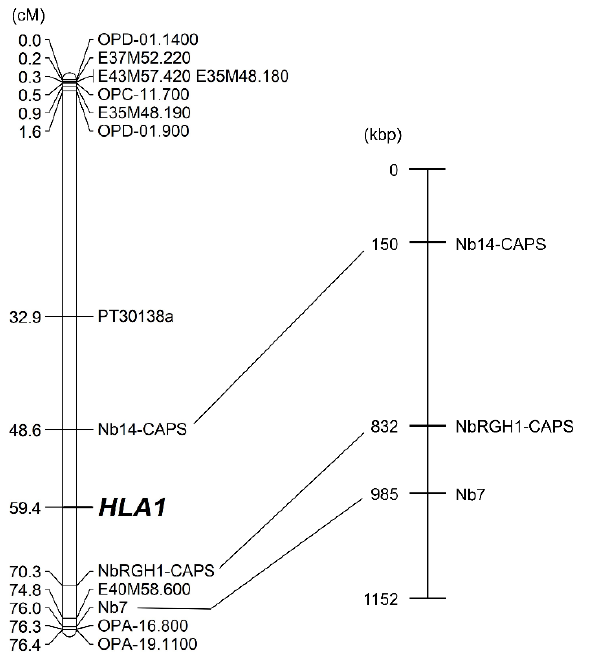
Figure 3. Linkage map ( left ) and physical map ( right ) indicating the position of the HLA1 locus. The physical map was based on the v1.0.1 genome of N. benthamiana .